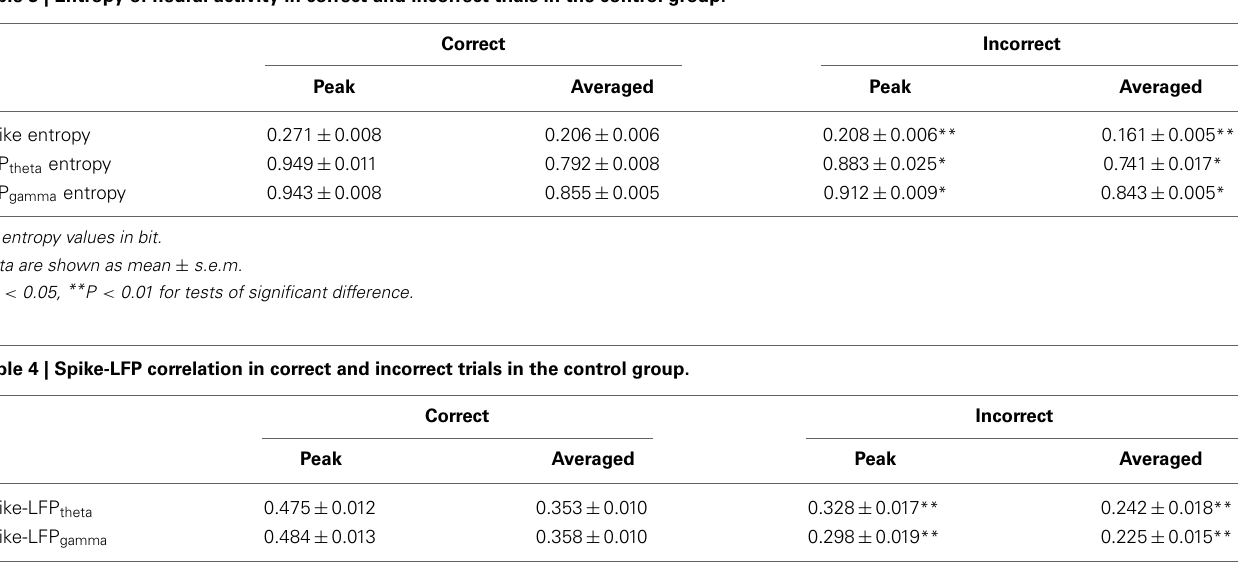
Data are shown as mean ±